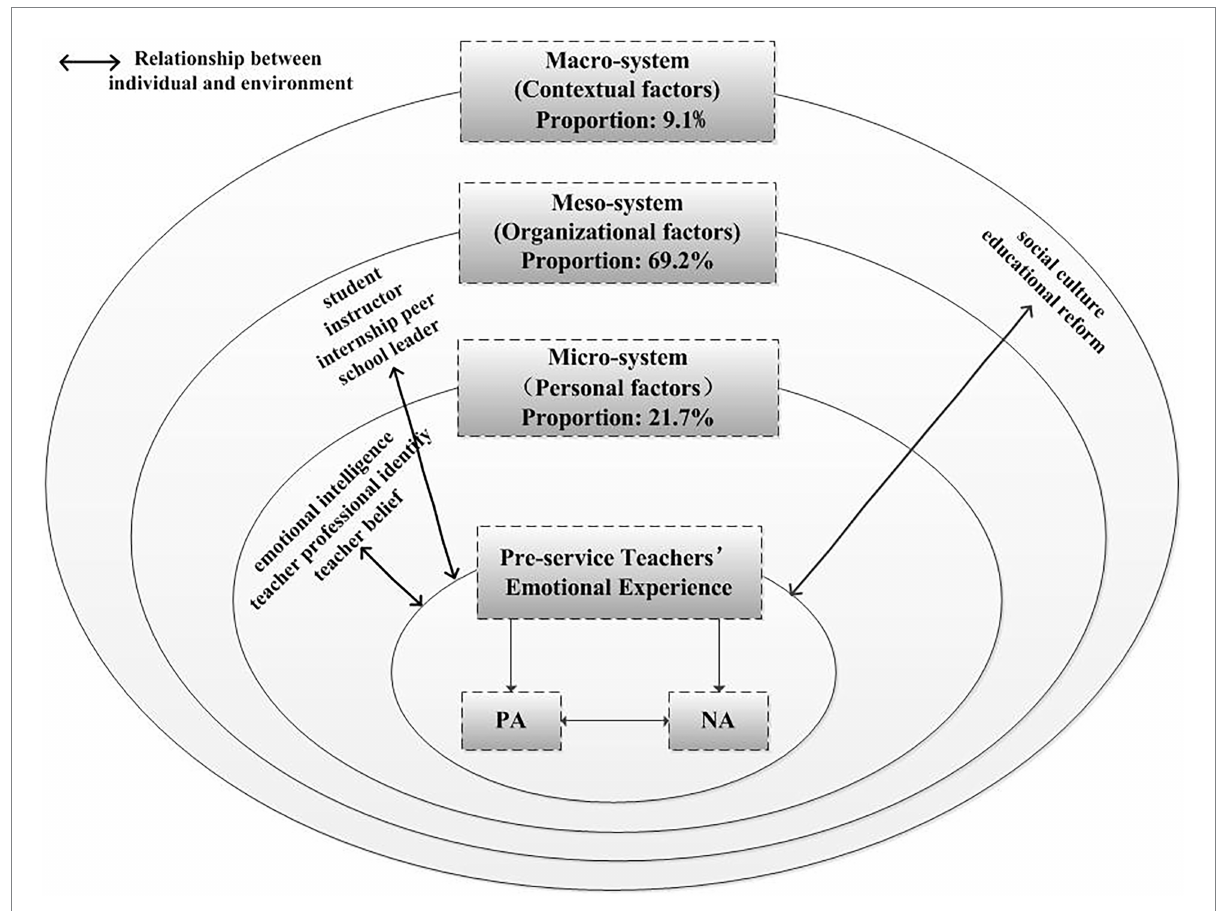
FIGURE 4 Revision map of influencing factors of pre-service teachers’ emotional